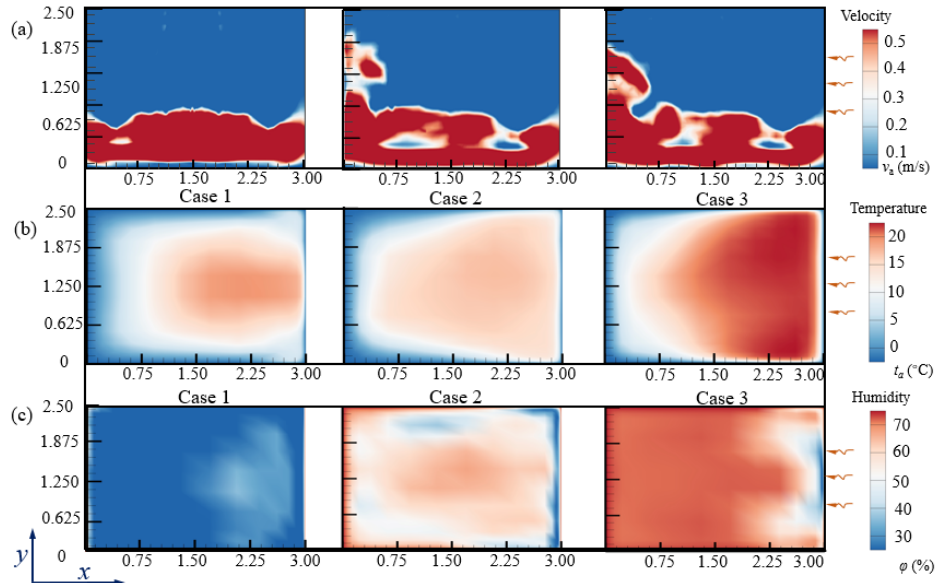
Figure 9. ( a ) Airflow velocity distribution, ( b ) temperature distribution, and ( c ) humidity distribution in the indoor thermal environment under operating conditions in Case 1 ( v a = 0.3 m/s, t a = 1 °C, φ = 30%), Case 2 ( v a = 0.5 m/s, t a = 15 °C, φ = 50%), and Case 3 ( v a = 0.7 m/s, t a = 25 °C, φ = 70%).